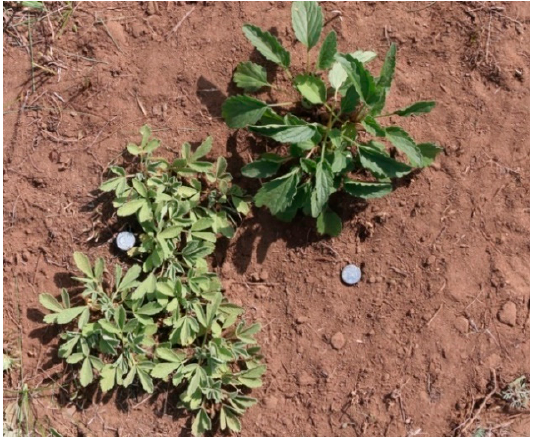
Figure 8. Photo of Potentilla chiesnsis from Baiyinkulun Grassland. Cichorium intybus